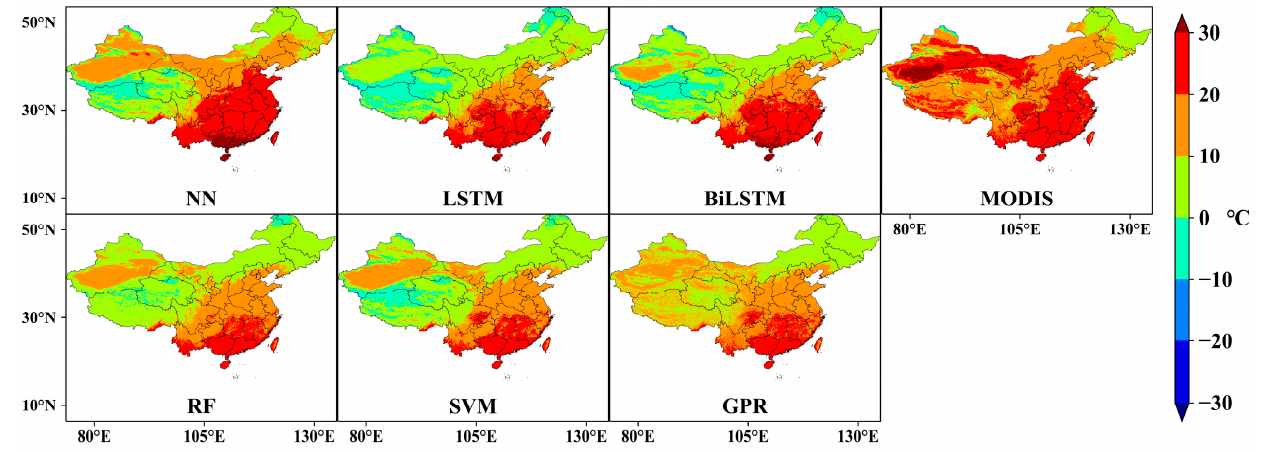
Figure 11. The NLSAT estimation results for the autumn of 2015.